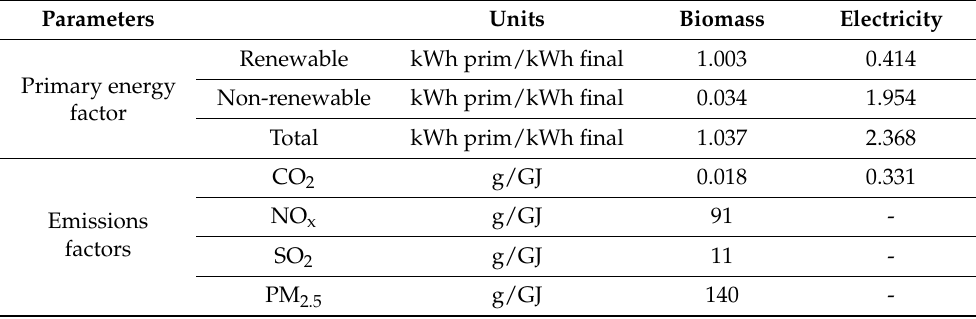
Table A4. Primary energy and emission factors.